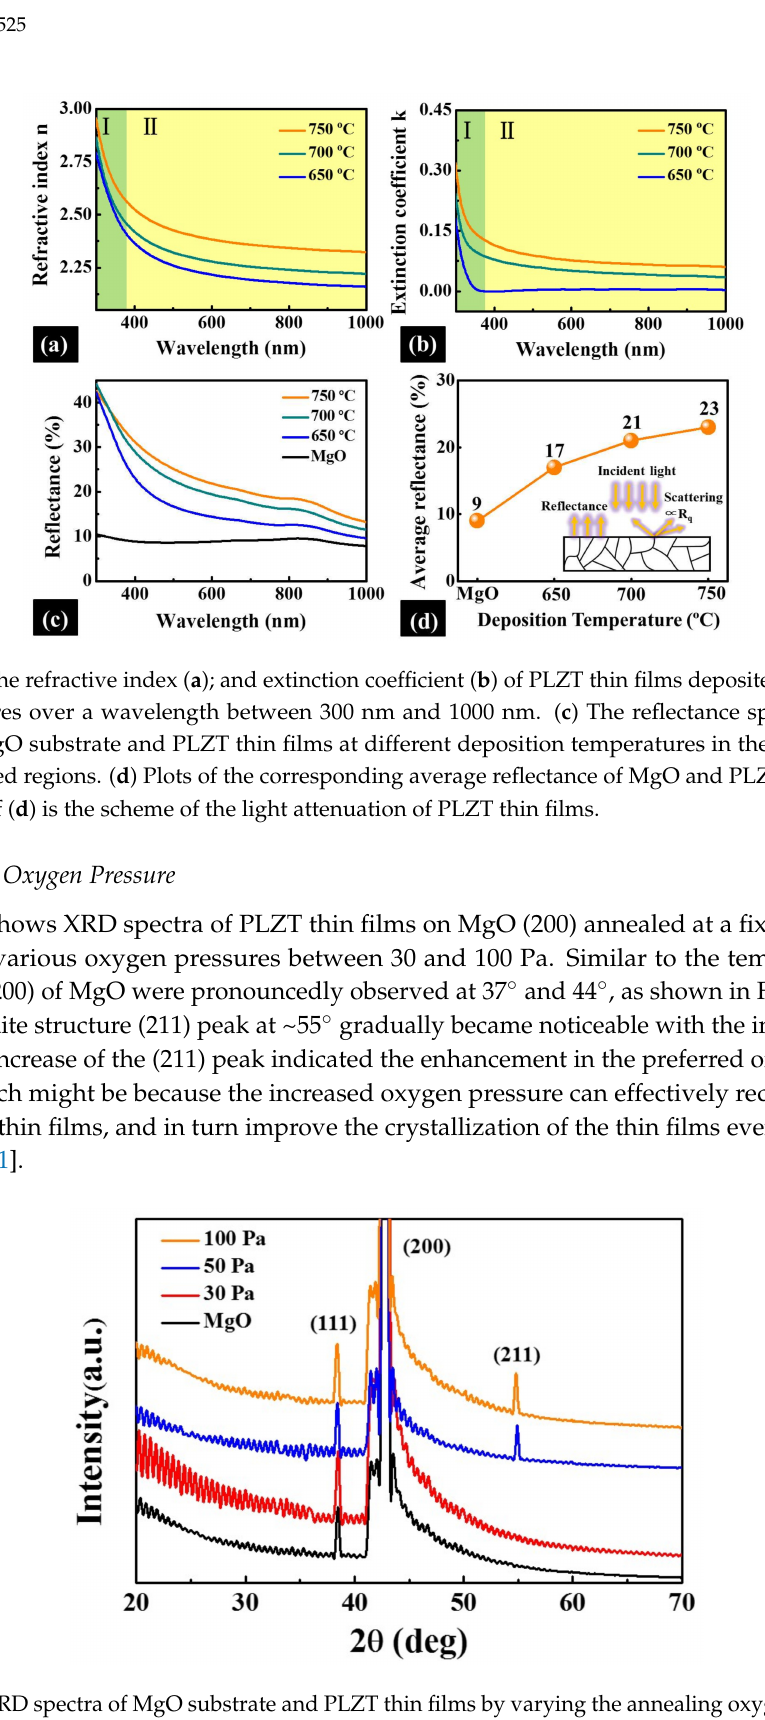
Figure 6. XRD spectra of MgO substrate and PLZT thin films by varying the annealing oxygen pressure at 30, 50 and 100